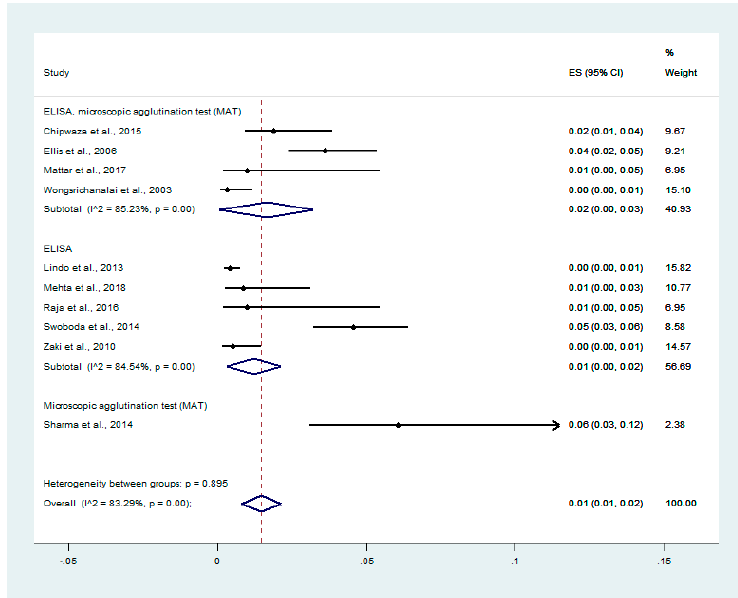
Figure 2. Prevalence of malaria and leptospirosis co-infection among febrile patients by diagnostic tests. % Weighted: the impact proportion of each study to the pooled effect; black dot symbol on black horizontal line: point estimate for each study; black horizontal line: CI, white diamond sym- bol: pooled prevalence; CI: confidence interval; ES: effect size (prevalence). The subgroup of countries showed that the pooled prevalence of malaria and lepto- Trop. Med. Infect. Dis. 2021 , 6 , x FOR PEER REVIEW spirosis co-infection among febrile patients was 5% in Bangladesh (95% CI: 3–6%), 2% in Tanzania (95% CI: 1–4%), 1% in Thailand (95% CI: 0–1%, I 2 : 98.1%), 0% in Jamaica (95% CI: 0–1%), 1% in Colombia (95% CI: 0–5%), and 1% in India (95% CI: 0–2%, I 2 : 59%). Over- all, the pooled prevalence of malaria and leptospirosis co-infection (86 cases) among fe- brile patients was 1% (95% CI: 1–2%, I 2 : 83.3%) (Figure 3).